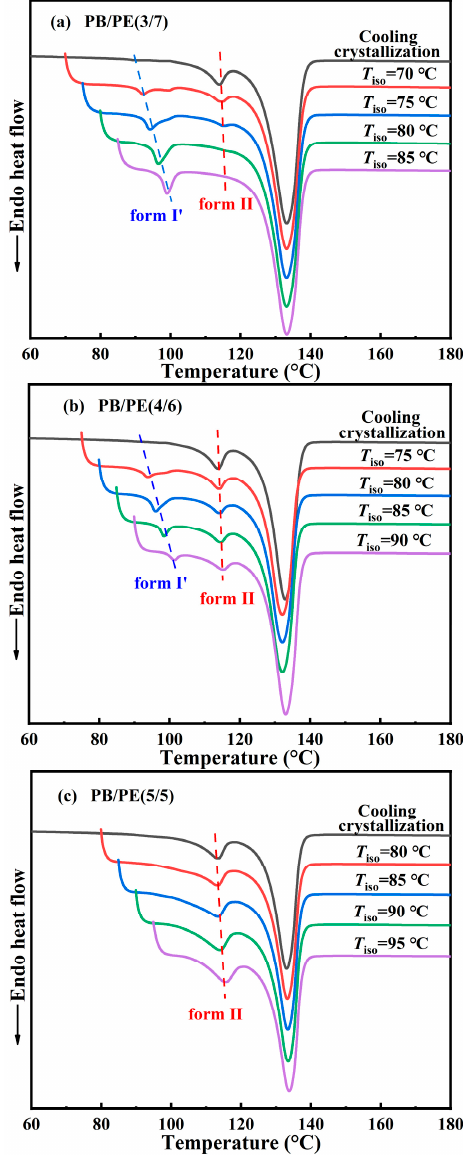
Figure 7. The DSC heating curves after isothermal crystallization at different temperatures for ( a ) PB/PE(3/7), ( b ) PB/PE(4/6), and ( c ) PB/PE(5/5).